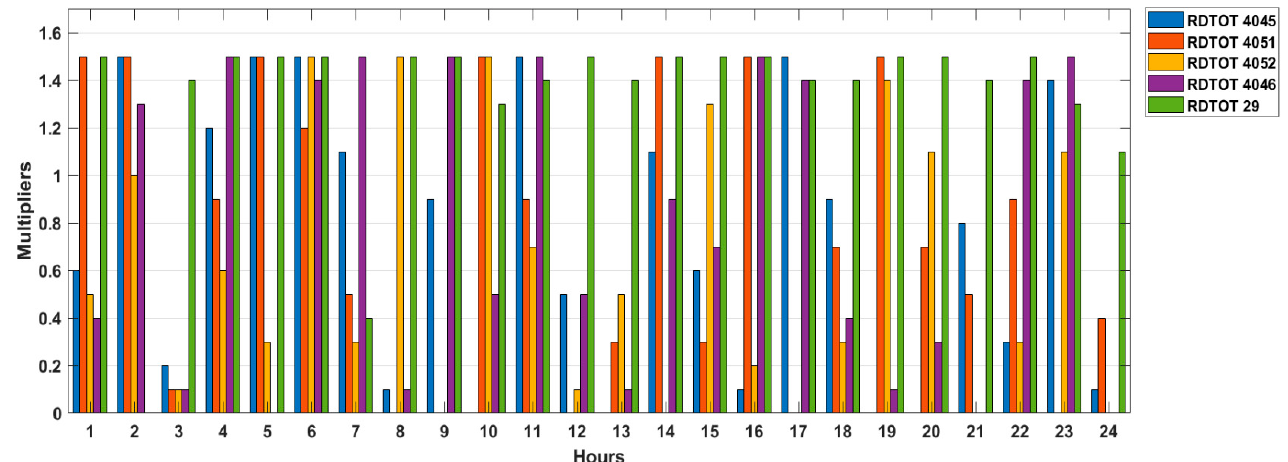
Figure 15. Pattern time dosage in Case 2 between local regulations.